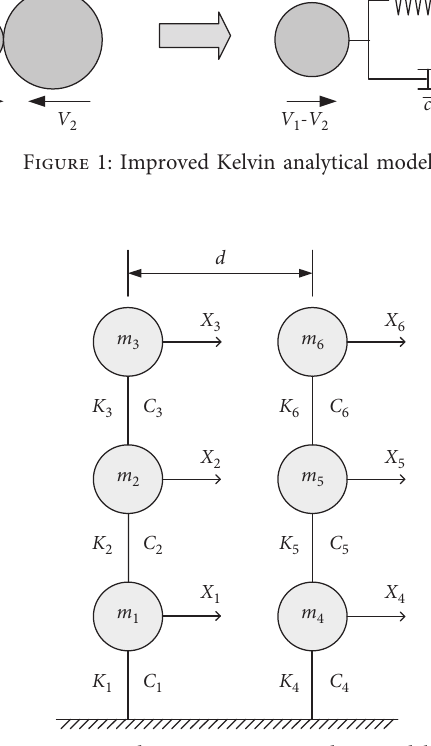
Figure 2: Adjacent MDOF pounding